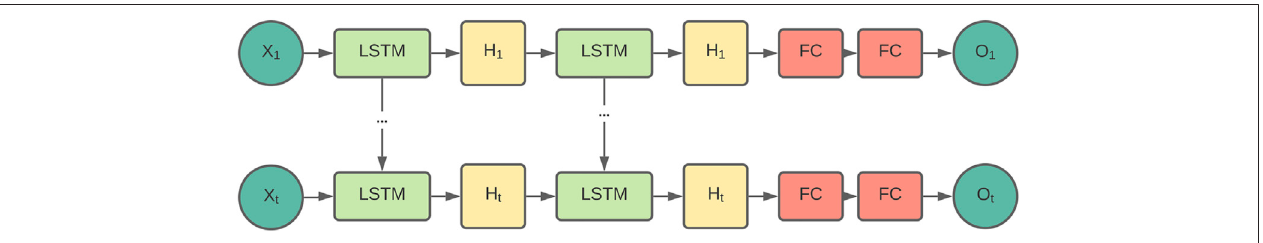
FIGURE 5 | LSTM-RNN model architecture. The input sequence { X i , i ∈ [1, T ]} is fi rst fed to two LSTM layers of hidden size 50. The intermediate representations ′ , i ∈ [ 1 , T ]} produced by the second LSTM layer are then processed by two FC layers to produce the output sequence { O { h i